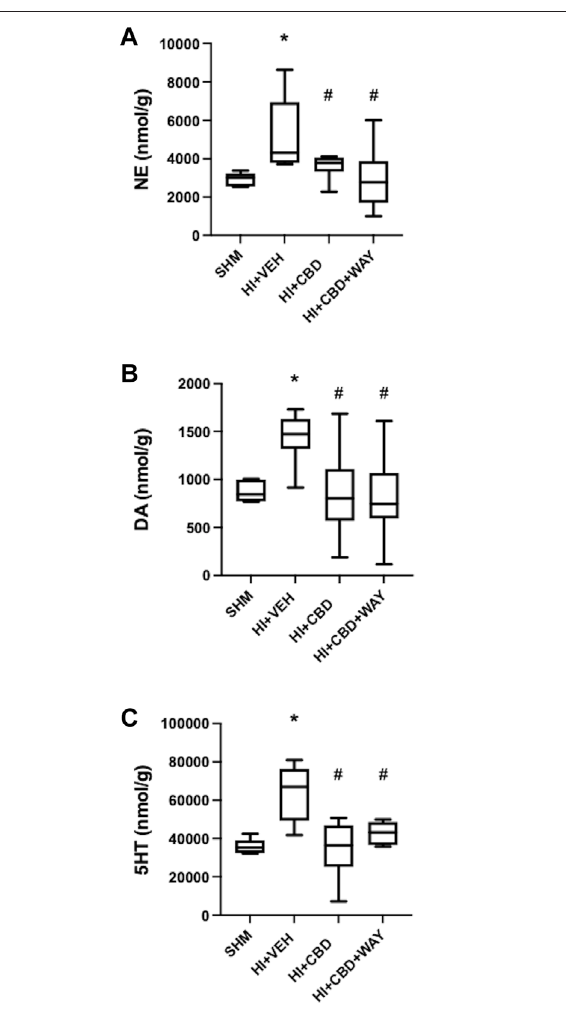
FIGURE 3 | Brain monoamine concentration 72 h after hypoxic – ischemicinsultinbrainsamplesfrompigletstreatedwithvehicle(HV), cannabidiol (HC), and WAY 100635 (HCW). Non-hypoxic – ischemic piglets served as controls (SHM). Boxes represent the median (IQR) and Whiskers ’ maximum and minimum values of brain concentration of (A) norepinephrine(NE), (B) dopamine(A),and (C) 5-hydroxytriptamine(5-HT).( p ) p < 0.05 vs. SHM and (#) p < 0.05 vs. HV by Kruskall – Wallis with Dunn ’ s test for multiple comparisons.